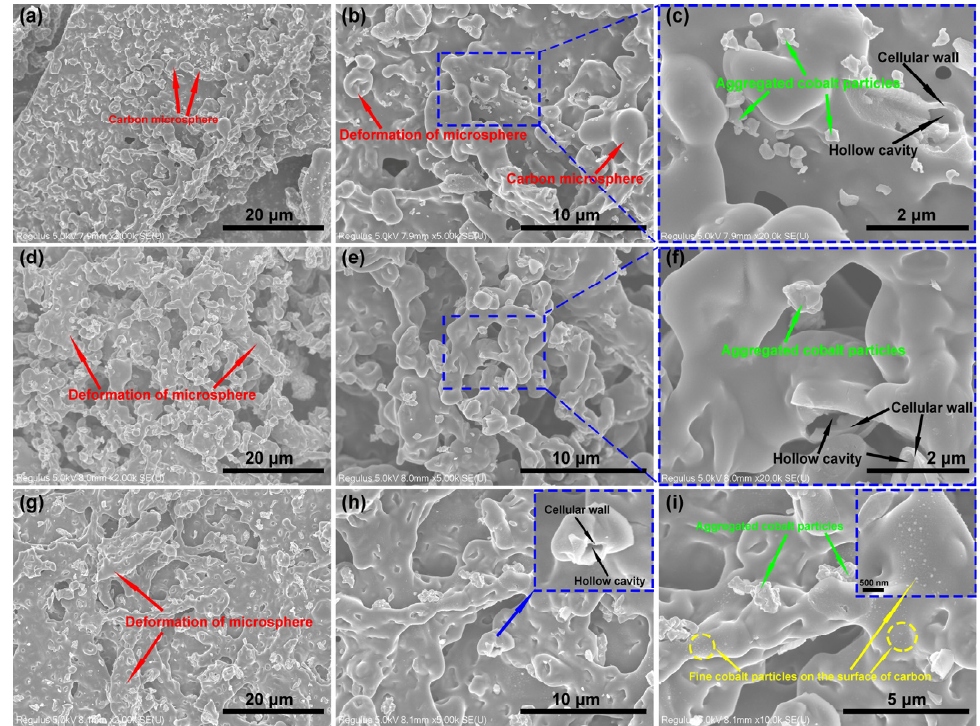
Figure 1. SEM images of ( a – c ) HC–Co–YC–0.025M, ( d – f ) HC–Co–YC–0.05M, and ( g – i ) HC–Co–YC– 0.075M.